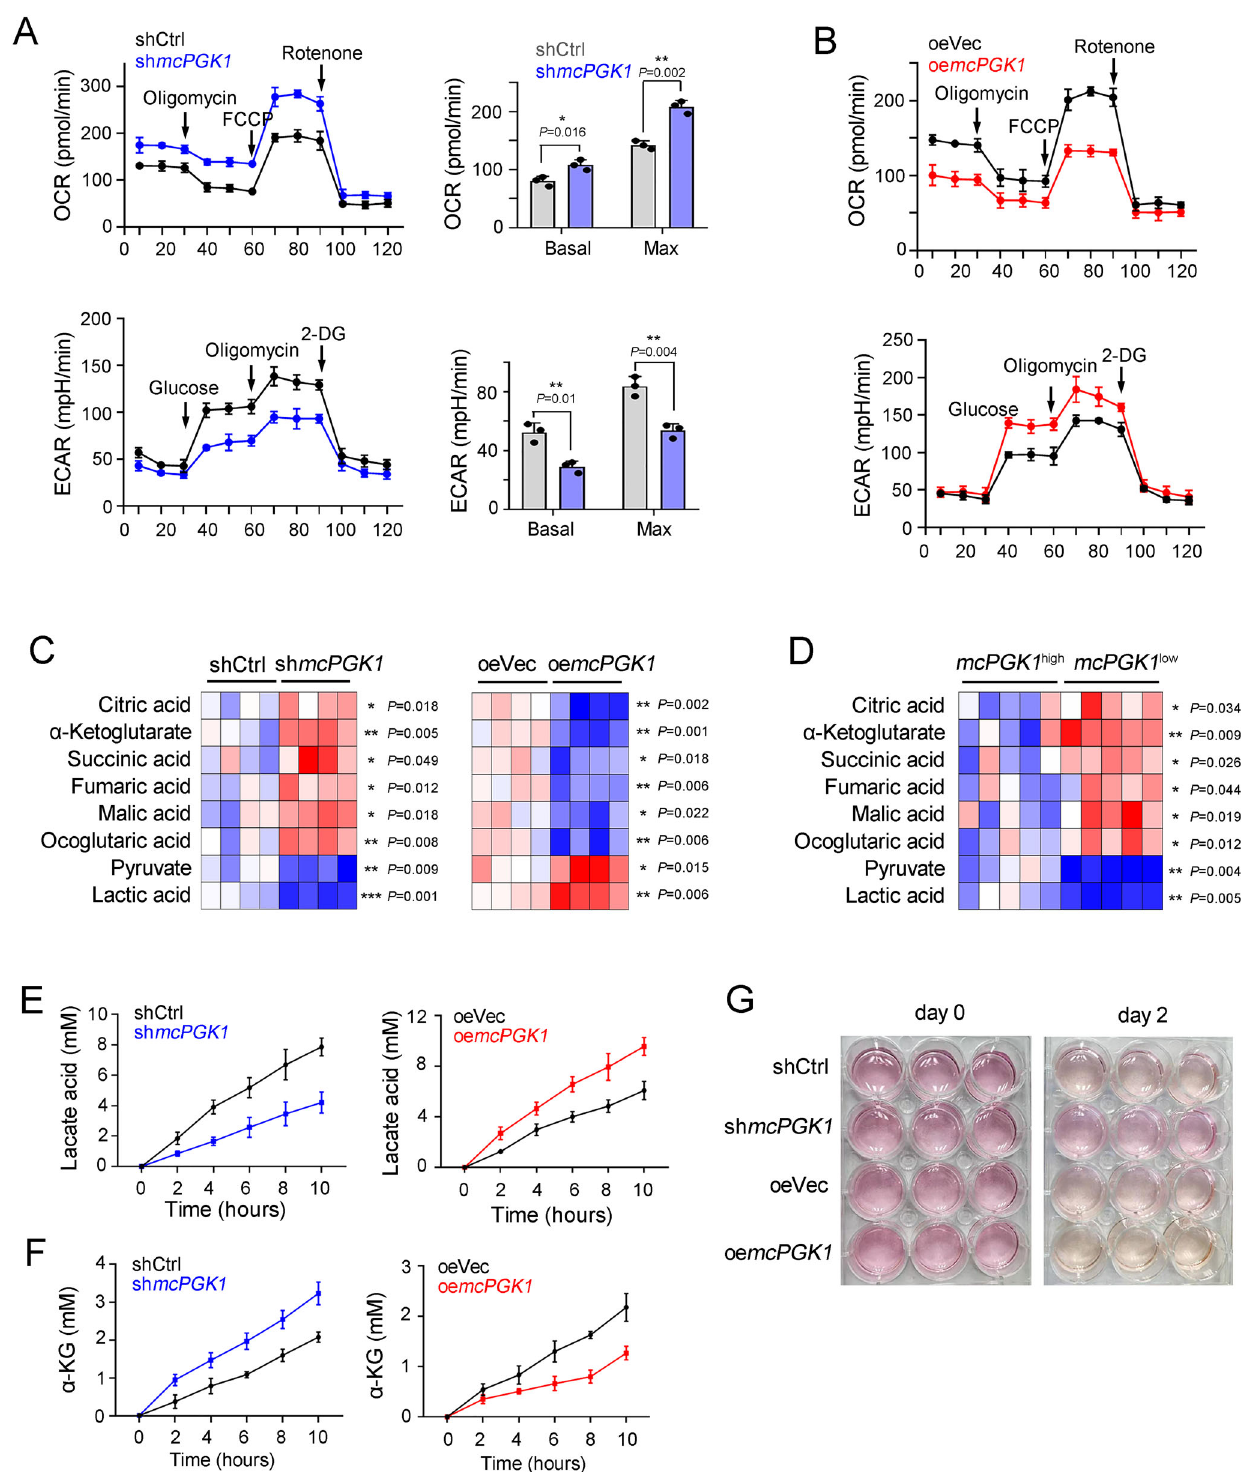
Fig. 3 | McPGK1 drives the metabolic reprogramming from OXPHOS to glyco- lysis. A , B Oxygen consumption rate (OCR) and extracellular acidi fi cation rate (ECAR) of mcPGK1 silenced ( A ) and overexpressing ( B ) cells. Huh7 cells were used for mcPGK1 knockdown( A )andHep3Bcellswereused for mcPGK1 overexpression ( B ). n =3 independent experiments for each cell. C Intracellular levels of the indi- cated metabolites in mcPGK1 silenced (left, sample #2) and overexpressing (right, sample#4)panels. n =4independentexperiments. D Five mcPGK1 high-expressing ( mcPGK1 high , sample #2, #3, #12, #10, #13) and mcPGK1 low-expressing ( mcPGK1 low , sample #4, #6, #7, #1, #15) samples were used for metabolite detection. E , F The